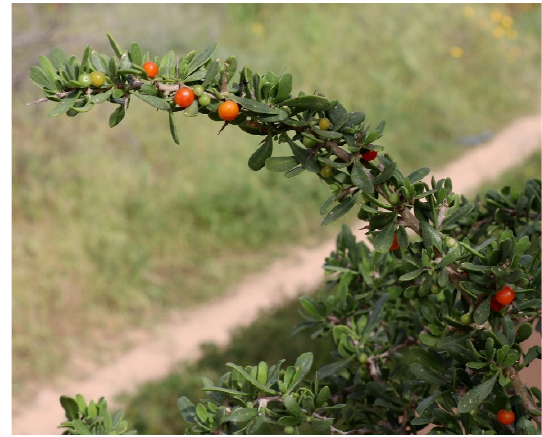
Figure 1. Lycium europaeum L. (Source: https://www.plantarium.ru/lang/en/page/image/id/560323.html) (accessed on 24 September 2022).